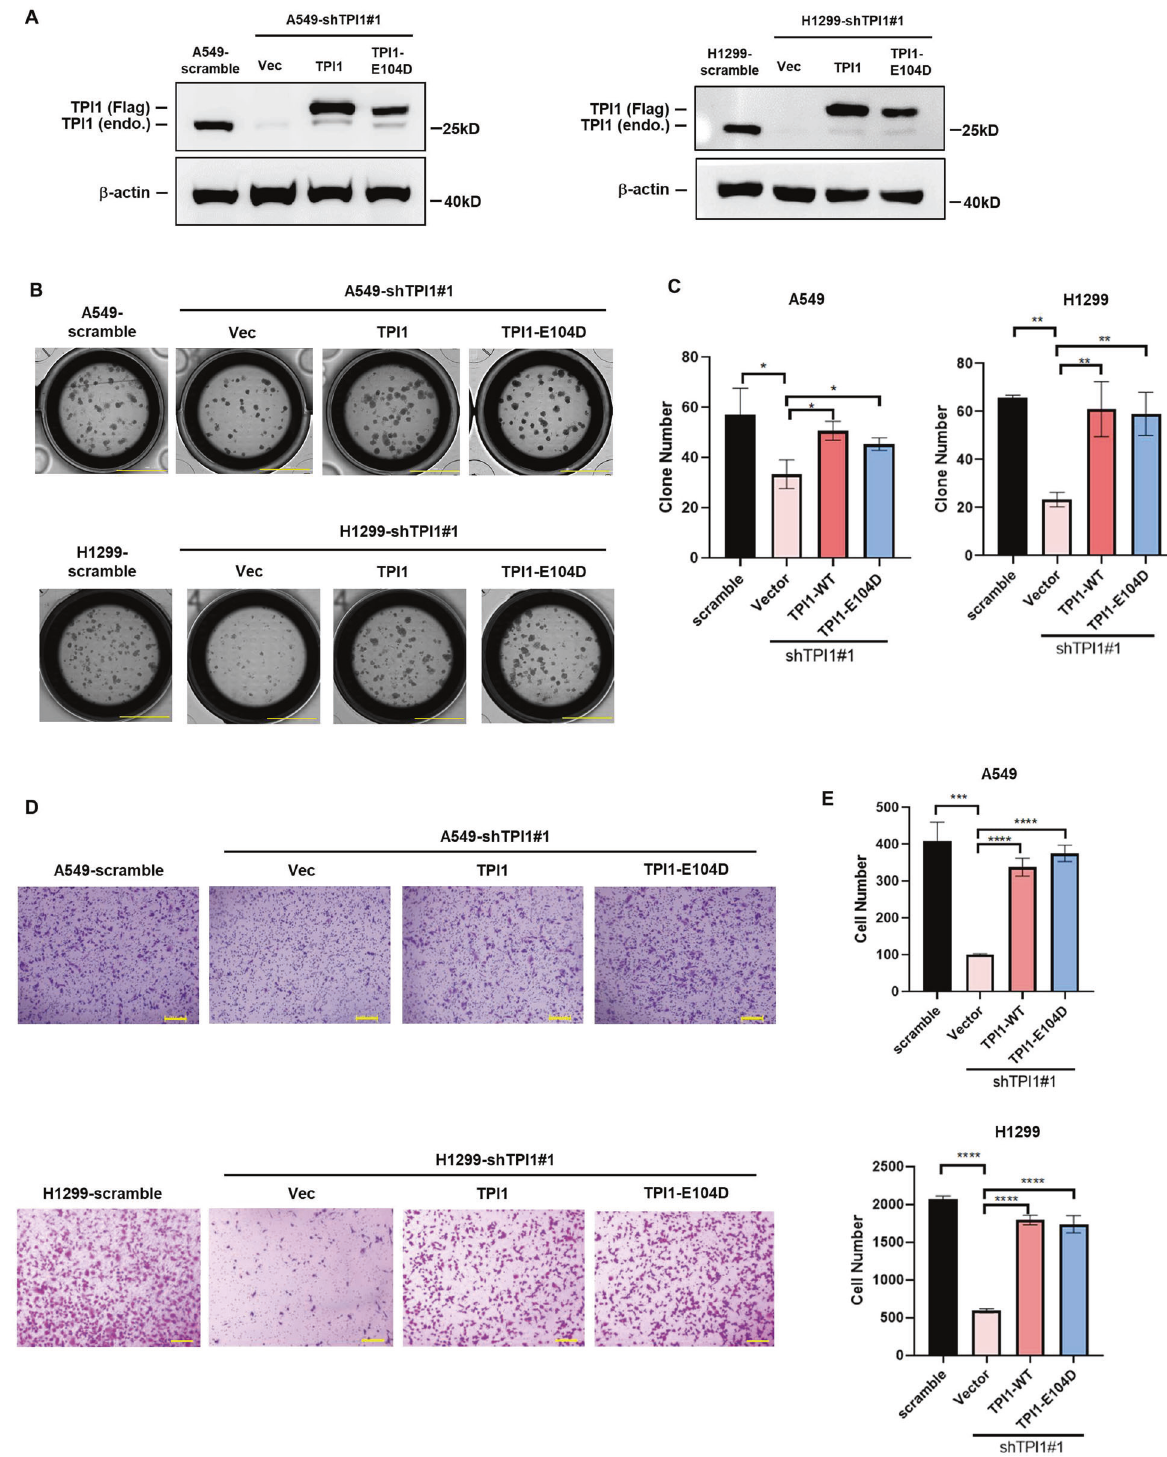
Fig. 3 The oncogenic function of TPI1 is independent of its enzymatic activity. A Western blot validating ectopic expression of wide-type and E104D mutant TPI1 in A549 and H1299 cells. B Both wild-type and E104D mutant of TPI1 recovered colony formation ability of A549 and H1299 cells. C Bar graphs show the quantitative analysis data of colony formation assay in ( B ). Data were shown as mean ± SEM from experiments performed in triplicate. Asterisks denote statistical signi fi cance with one-way ANOVA. * p < 0.05 for the indicated comparison. D Both wild-type and E104D mutant of TPI1 recovered migration ability of A549 and H1299 cells. E Bar graphs show the quantitative analysis data of transwell assay in ( D ). Data were shown as mean ± SEM from experiments performed in triplicate. Asterisks denote statistical signi fi cance with one-way ANOVA. *** p < 0.001; **** p < 0.0001 for the indicated comparison.